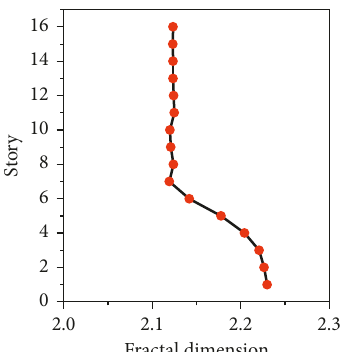
Figure 21: FDs of the TFFs of interstory displacements of the structure under PGA